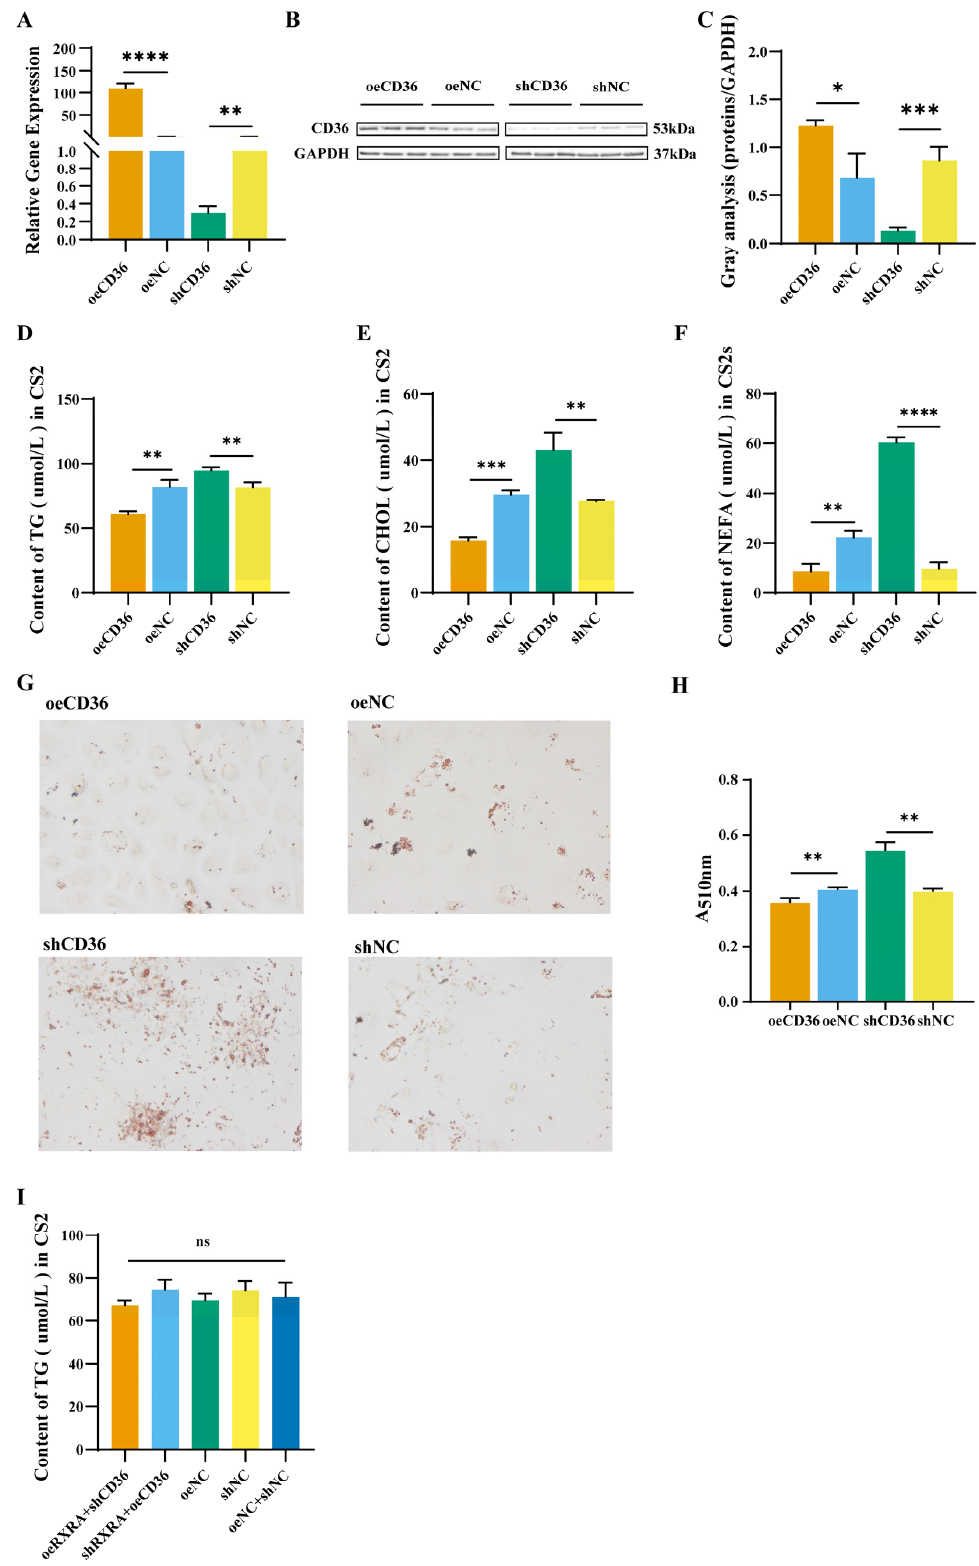
Figure 4. CD36 gene inhibits the contents of TGs, CHOL, and NEFAs in myoblasts. ( A ) Relative mRNA expression levels of CD36 in CS2 cells transfected with oeCD36, oeNC, shCD36, and shNC. ( B ) The indicated protein levels were detected by western blot analysis. ( C ) The relative fold change in CD36/GAPDH as determined by western blotting was quantified through a gray scale scan. TG